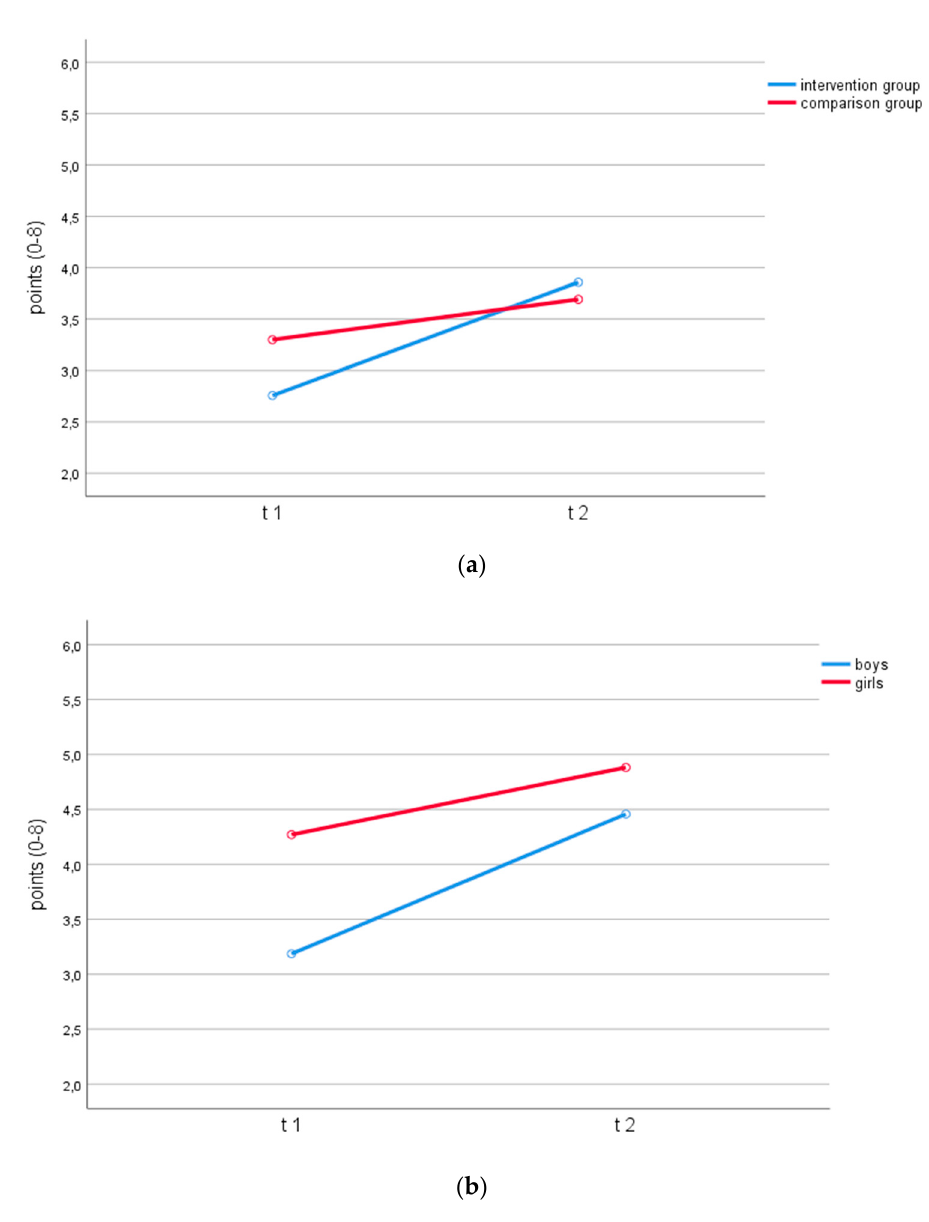
Figure 2. ( a ) Motor competencies of intervention and comparison group in object movement . ( b ) motor competencies of boys and girls in self-movement .